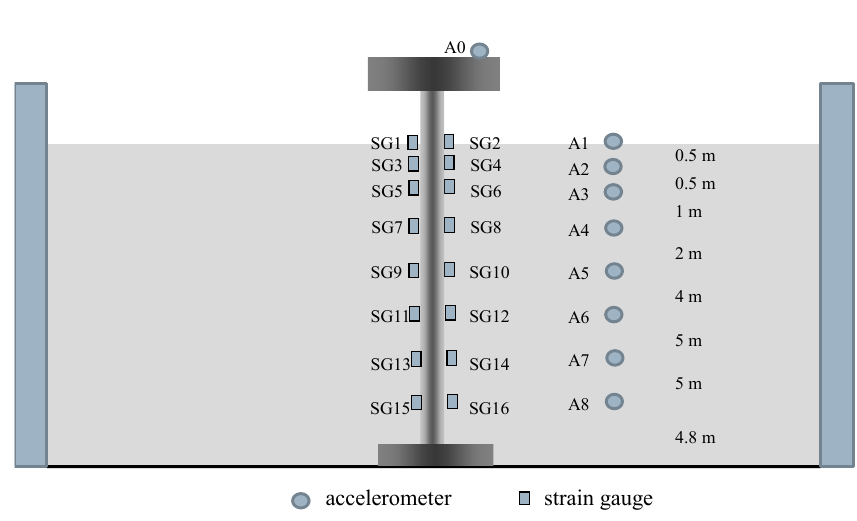
Figure 4. Layout of test (in prototype)